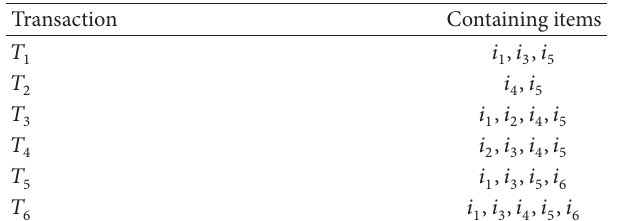
Table 2: An example of transation